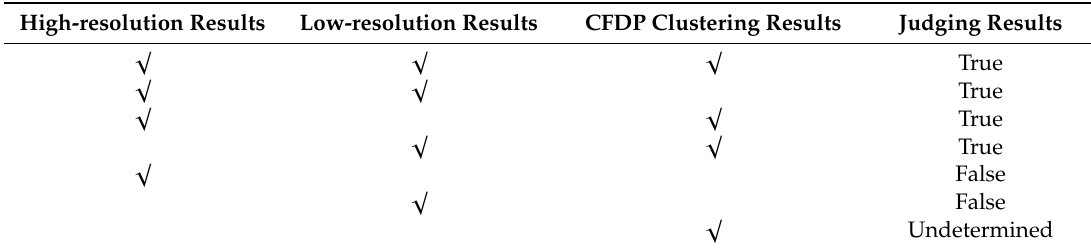
Table 1. Fusion Rules. CFDP, clustering method via fast searching and the finding of density peaks. High-resolution